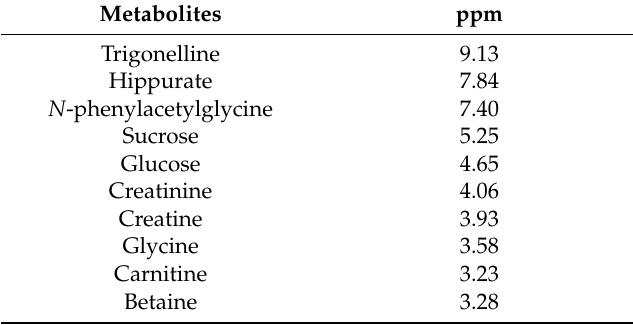
Table 3. Urinary metabolites considered for the pathway analysis and positions in the 1 H-NMR spectrum of the corresponding selected peaks.